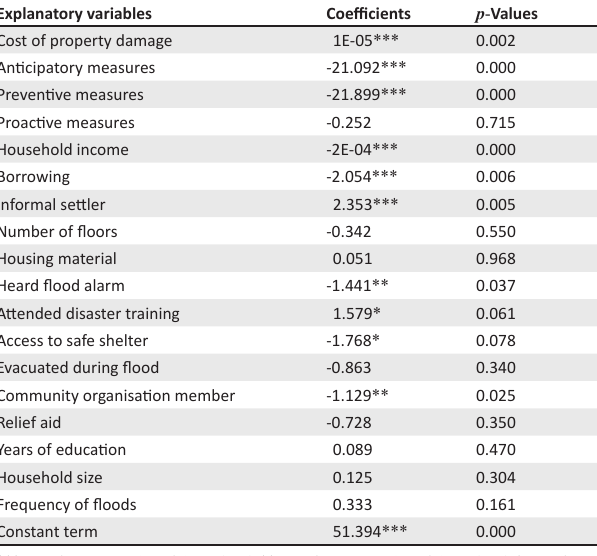
TABLE 9: Results of interval regression